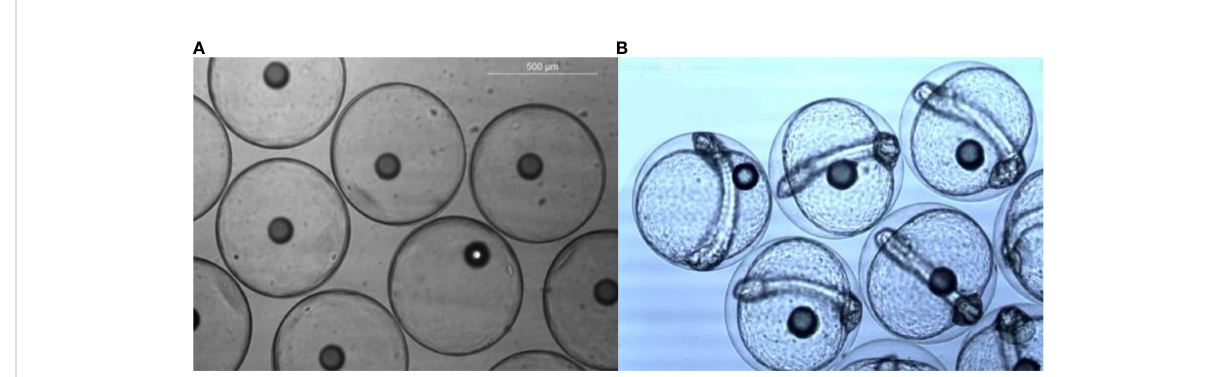
FIGURE 7 P. marcia (A) fertilised egg (B) optic vesicle